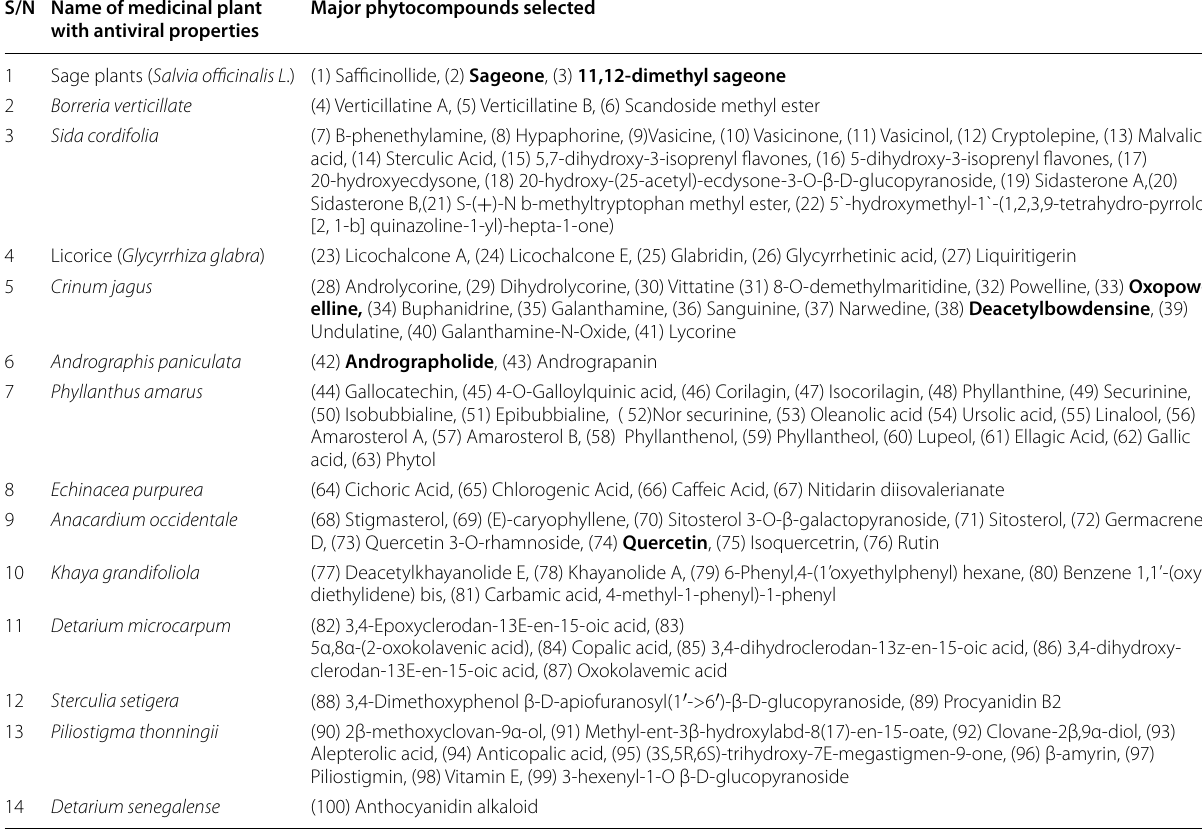
Table 1 List of phytocompounds (numbered 1–100) obtained from 14 Nigerian medicinal plants having antiviral properties S/N Name of medicinal plant Major phytocompounds with antiviral properties